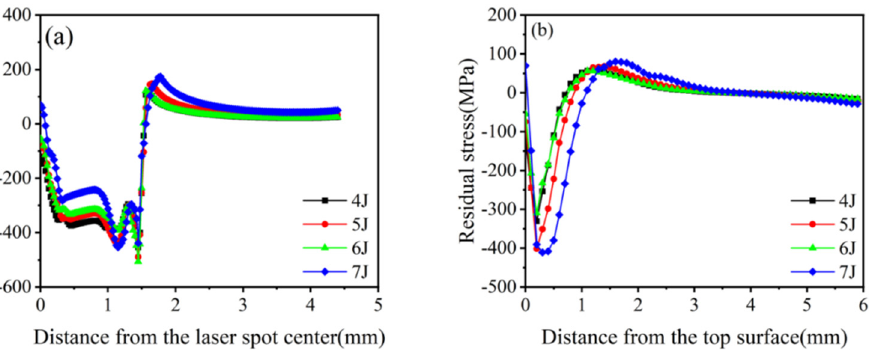
Figure 6. Residual stresses in 20CrMnTi at different laser pulse energies. ( a ) Surface residual stress distribution; ( b ) Depth direction residual stress distribution.